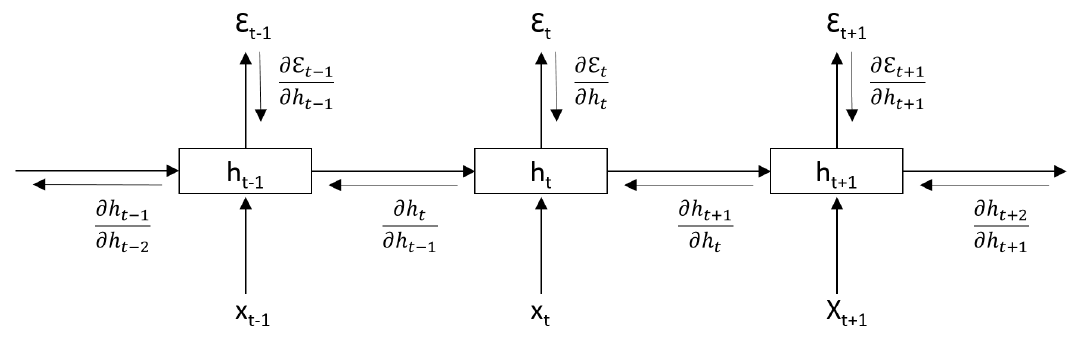
Figure 6. The RNN here has been unrolled for three time steps for some arbitrary sequential data. At every time step, the RNN’s output is computed, as well as the hidden state is passed forward through time. During back-propagation, the gradients flow back in two paths; first from error outputs at every time step ∂ E t , as well as the gradient back-flow through time through the recurrent states, ∂ h t + 1 ∂ h t